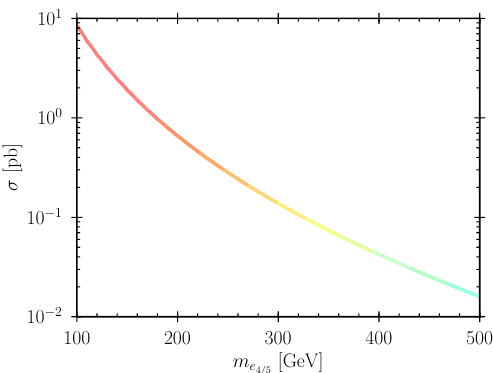
e (cid:6) (cid:23) 4 production at p s = 13 TeV as a function of the heavy 4 = 5 (cid:0)!